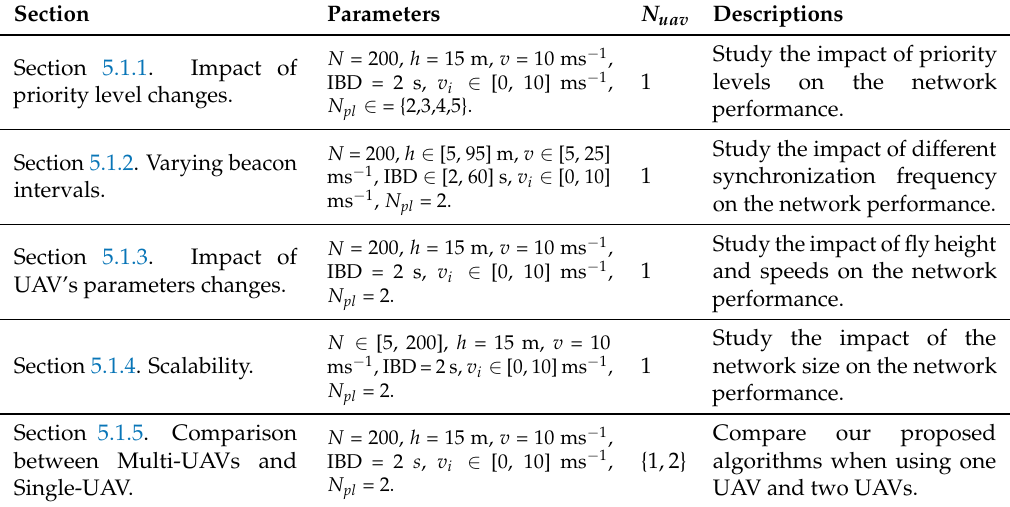
Table 5. Summary of simulations.